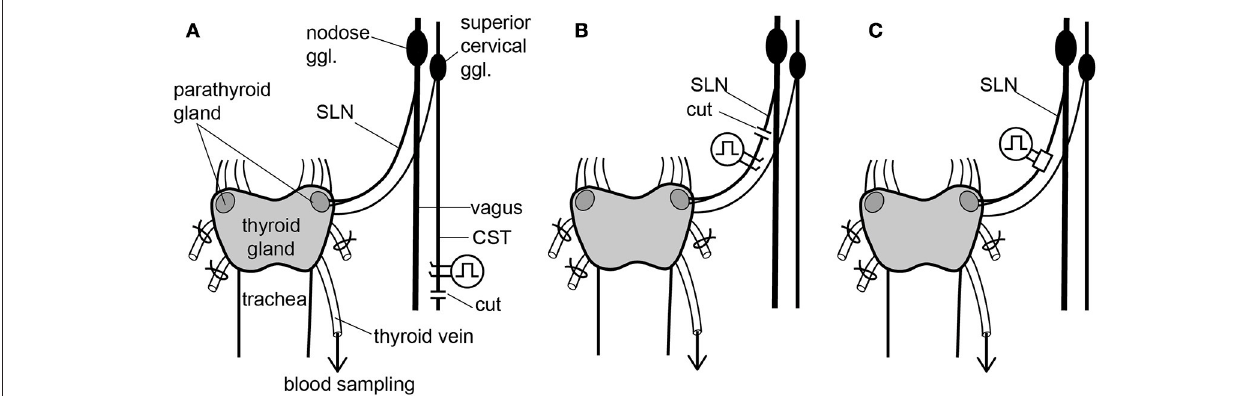
FIGURE 1 | Schematic diagram of the sympathetic (cervical sympathetic trunk: CST) and parasympathetic (superior laryngeal nerve: SLN) innervation of thyroid and parathyroid glands and the arrangements of stimulating electrodes in the three experimental groups. Electrical stimulation was delivered bilaterally to either the CSTs or the SLNs. Only the left CST and SLN are drawn for clarity, but experimental preparations were stimulated bilaterally. (A) Stimulation of cut peripheral CST ends by hook electrodes. (B) Stimulation of cut peripheral SLN ends by hook electrodes. (C) Stimulation of intact SLNs by cuff